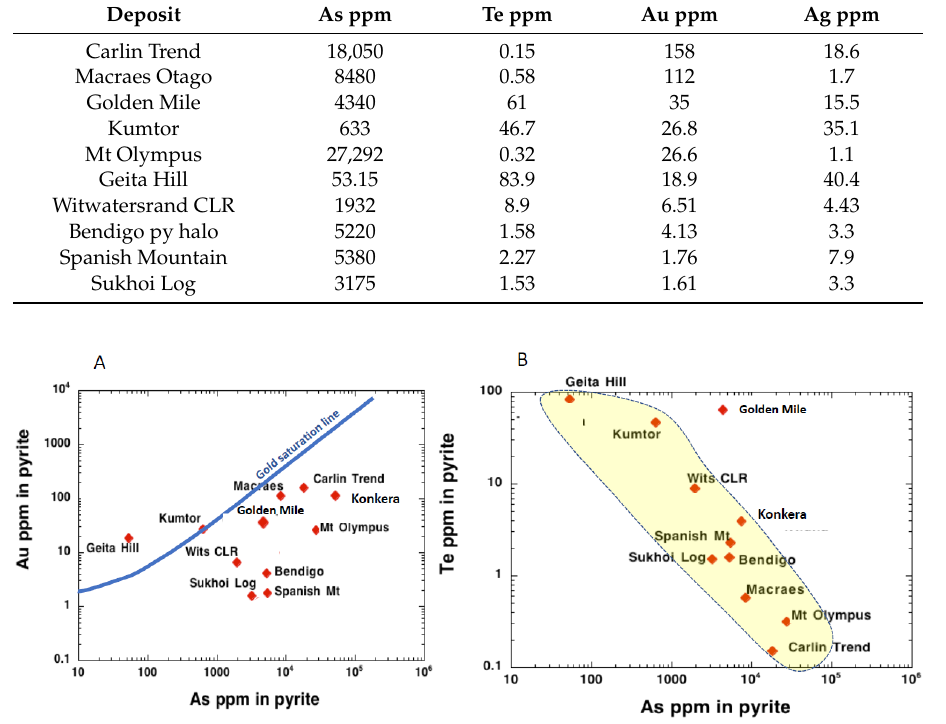
levels of Ag and a Ag/Au ratio of 1.0 to 10. This is due to the common link between Ag and Te forming